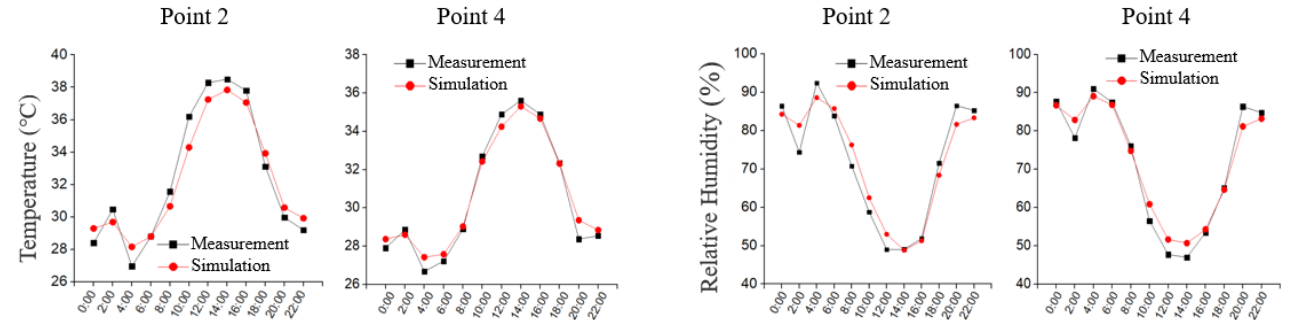
Figure 8. Comparison of measurement and ENVI-met simulation results at points 2 and 4.